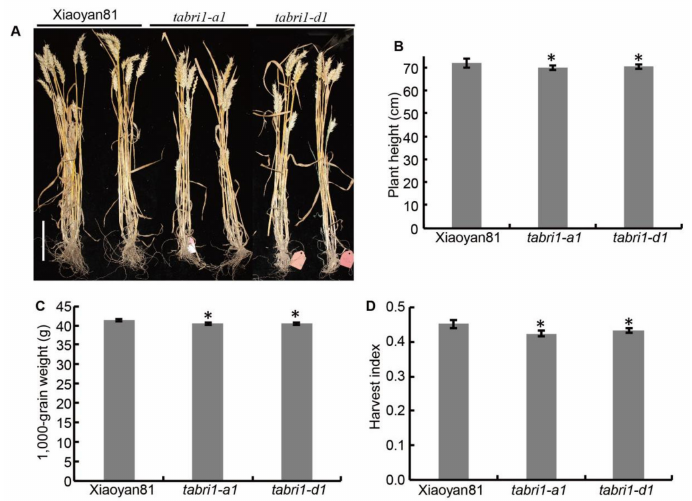
Figure 5. The yield traits in WT, TaBRI1-A1 and TaBRI1-D1 mutants. ( A ) Phenotypes of TaBRI1-A1 and TaBRI1-D1 mutants at maturity. Bar = 15 cm; ( B ) plant height; ( C ) 1000-grain weight; ( D ) Harvest index. All phenotypic data were measured from field-grown plants under normal cultivation conditions. Each genotype had three biologic replicates, and each biologic replicate comprised fifteen plants. * indicates significant di ff erences between WT and TaBRI1 mutants at p <